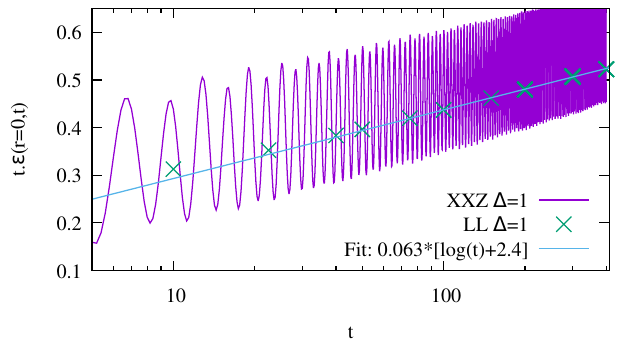
Figure 16: Energy density ε ( r = 0, t ) in the center of the system and multiplied by t , plotted as a function of t (logarithmic scale). The green crosses correspond to the LL model and the purple curve corresponds to the quantum chain (both at ∆ = 1). The data are compatible with a logarithmic increase with time (see fitting function in the legend, blue line).